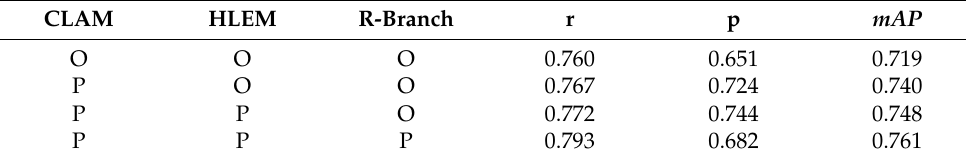
Table 8. Overall effectiveness of the